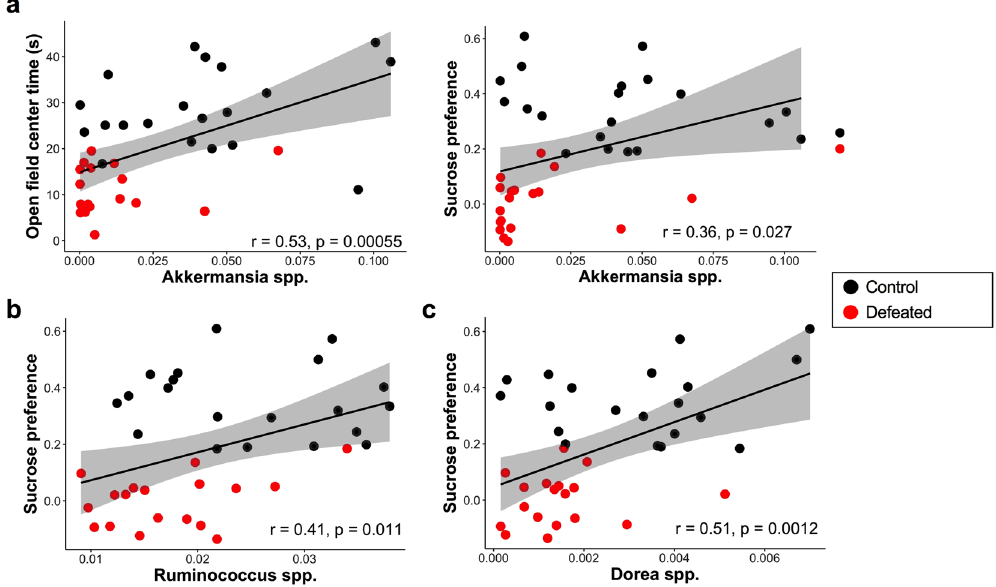
Figure 3. Akkermansia spp., Dorea spp., and Ruminococcus spp. levels correlate with depressive-like behavior. ( a ) Correlation analysis for the relative abundance of Akkermansia spp. and time spent in the center of the open field maze (Spearman r = 0.53, p < 0.000) (n = 39 pairs) as well as sucrose preference (Spearman r = 0.36, p < 0.05) (n = 38 pairs). ( b , c) Analysis also revealed a positive correlation between the relative abundance of both Ruminococcus spp. (Spearman r = 0.41, p < 0.05) (n = 38 pairs) and Dorea spp. (Spearman r =